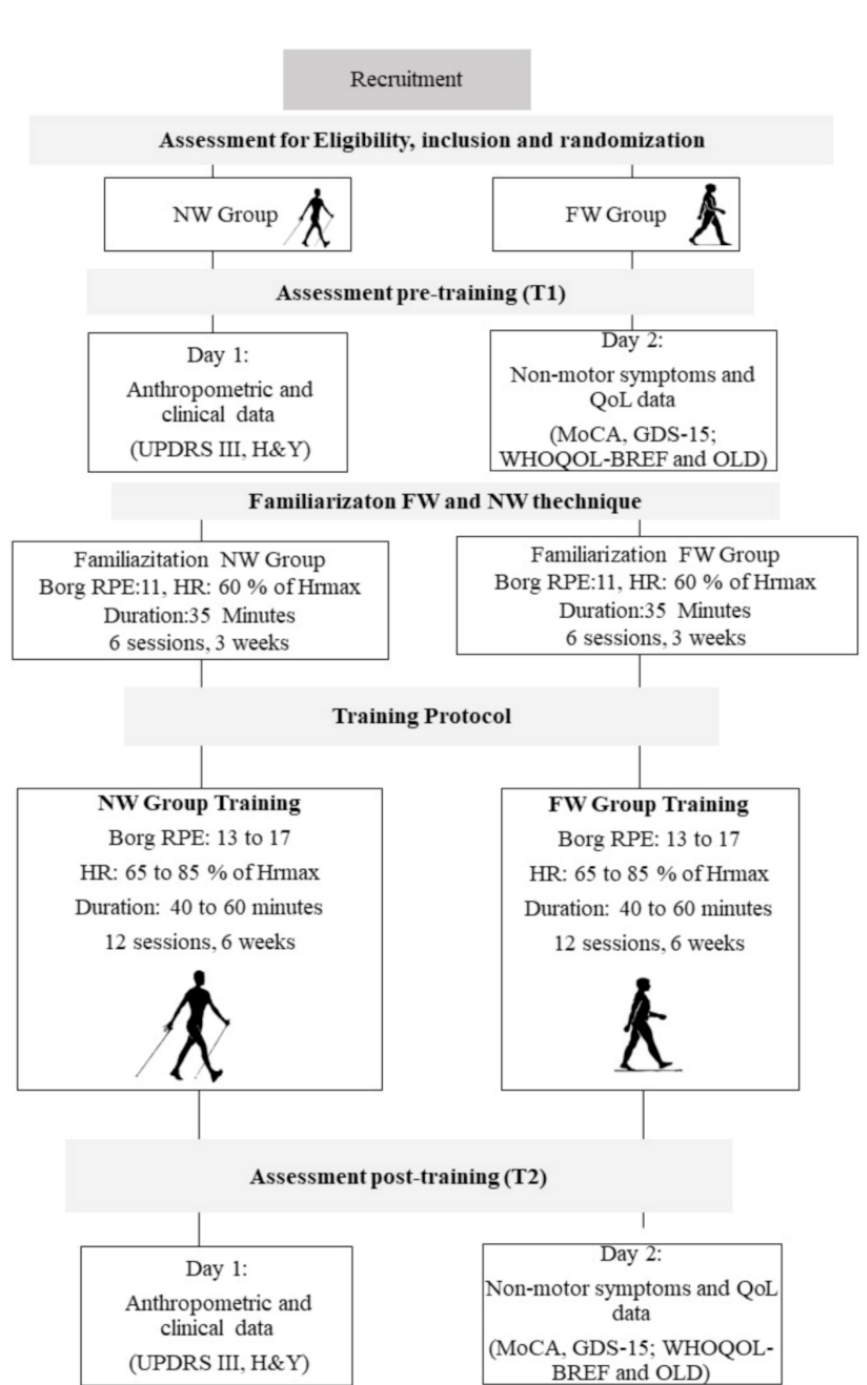
Figure 1. Timeline of the study. NW: Nordic walking, FW: Free walking, MoCA: Montreal cognitive assessment, UPDRS III: Unified Parkinson Disease Rating Scale—Part Motor, H&Y: Hoenh and Yahr scale, SSWS: Self-selected walking speed, RPE: Rating of perceived exertion, HR: Heart